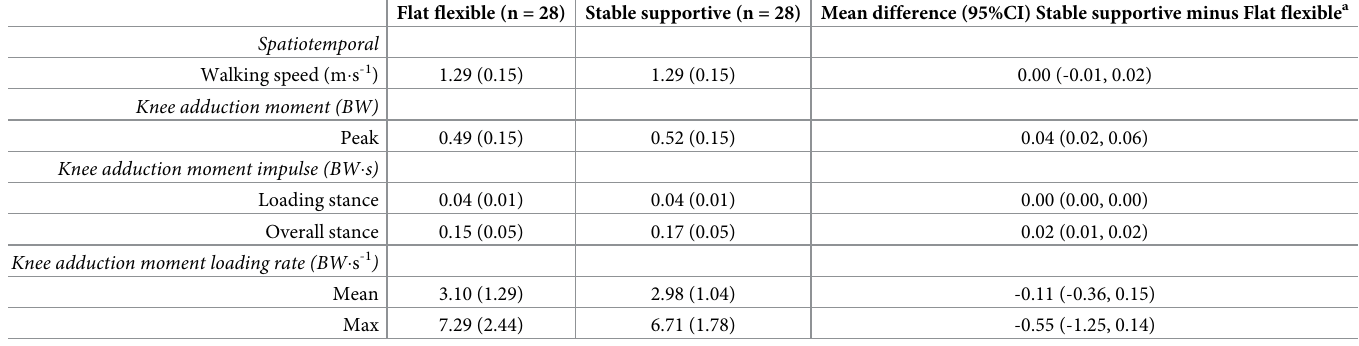
Table 3. Mean change (SD) in spatiotemporal and discrete knee adduction moment variables for flat flexible and stable supportive shoes, with accompanying mean differences (95% confidence intervals